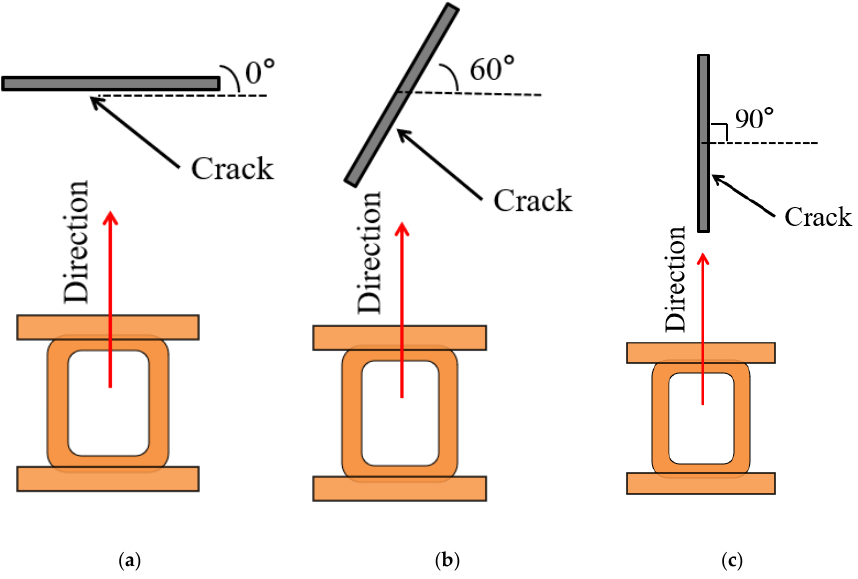
Figure 10. The schematic diagram of the crack defect scanning angle: ( a ) 0°; ( b ) 45°; ( c ) 90°.